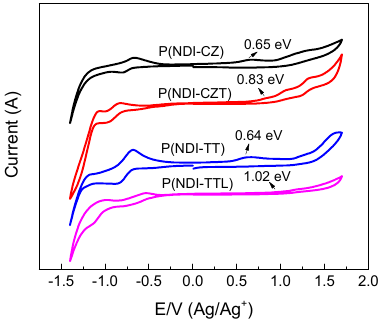
Figure 7. The cyclic voltammograms of polymers (0.1 M tetrabutylammonium hexafluorophosphate (TBAPF6) in CH 2 Cl 2 solution, the scan rate was 30 mV·s − 1 ).